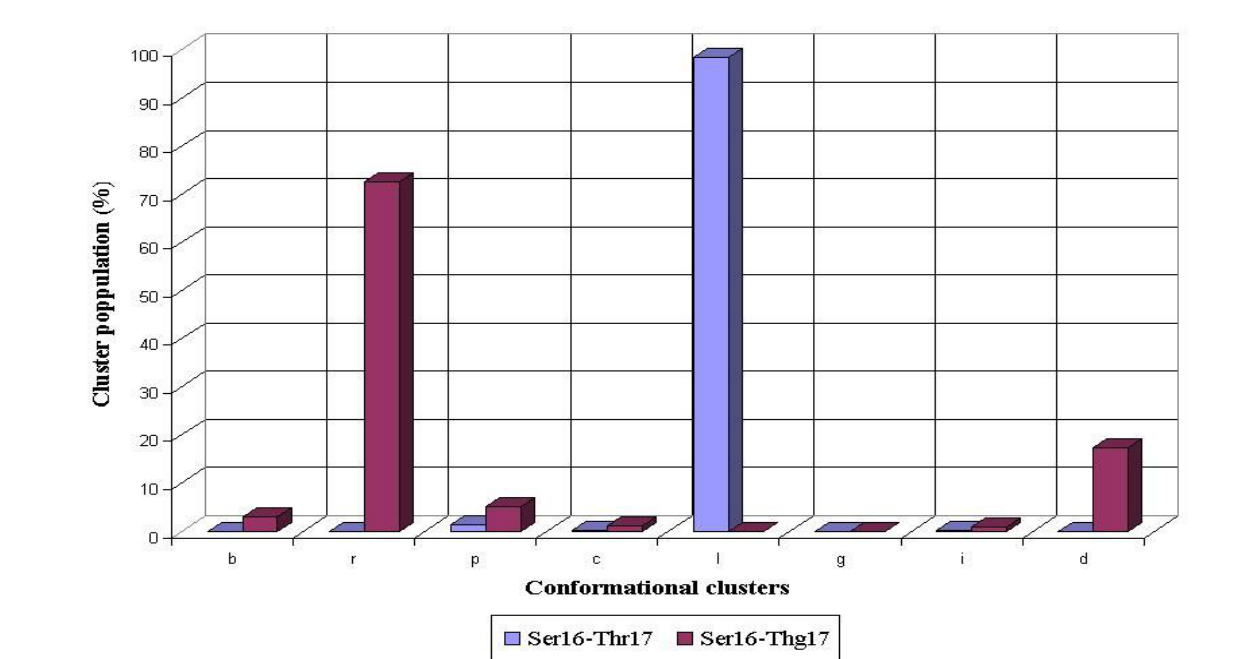
Figure 5. Conformational propensities of Ser16 flanking the nonglycosylated (Ser16-Thr17) and glycosylated (Ser16- Thg17) threonine residue during 1 ns MD simulations in peptides AHG21 and AHG21 (T17),